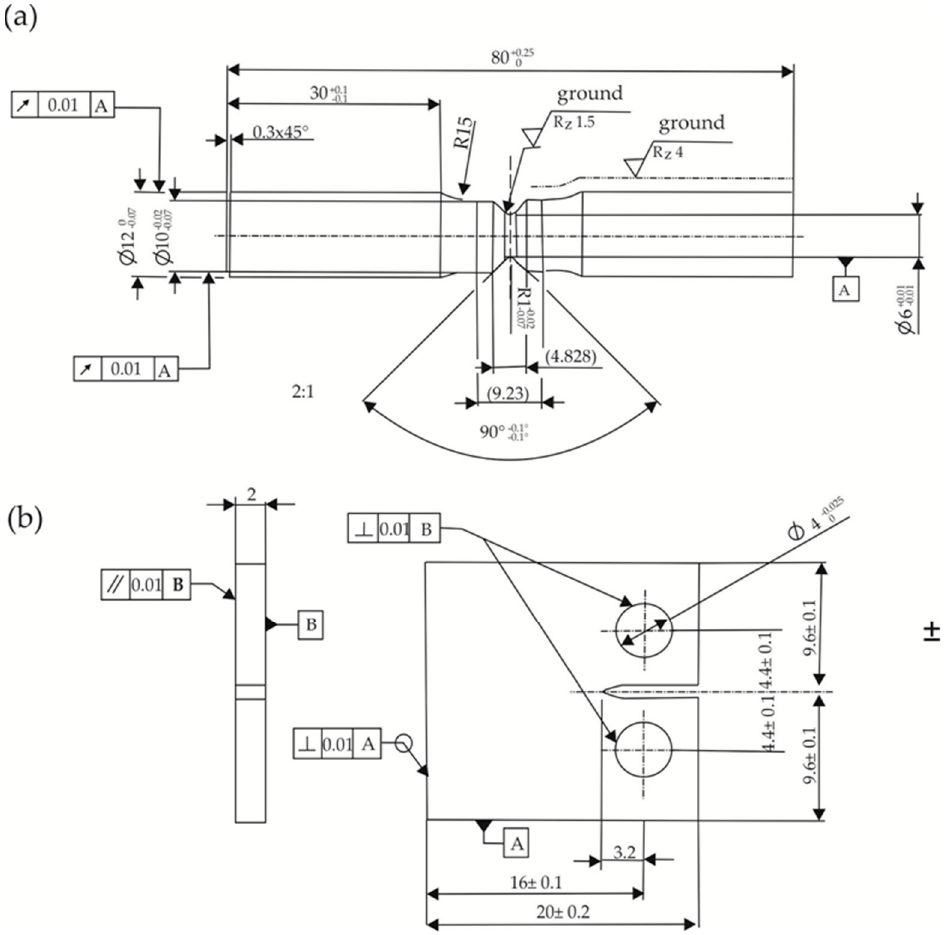
Figure 3. ( a ) Draft of round specimen with K t = 2 for fatigue testing; and ( b ) draft of CT-Specimen for crack growth experiments. Table 2. Overview of the results of the microstructural analysis, l block and c block , fatigue limits σ a,50% for the different tested load ratios and notch geometries of the specimens, threshold values for long fatigue crack growth K th determined by crack growth experiments and critical crack length a * determined for the different tested load ratios and notch geometries of the specimens determined out of Kitagawa diagrams. *) determined from specimens with notch factor K t = 1.89.